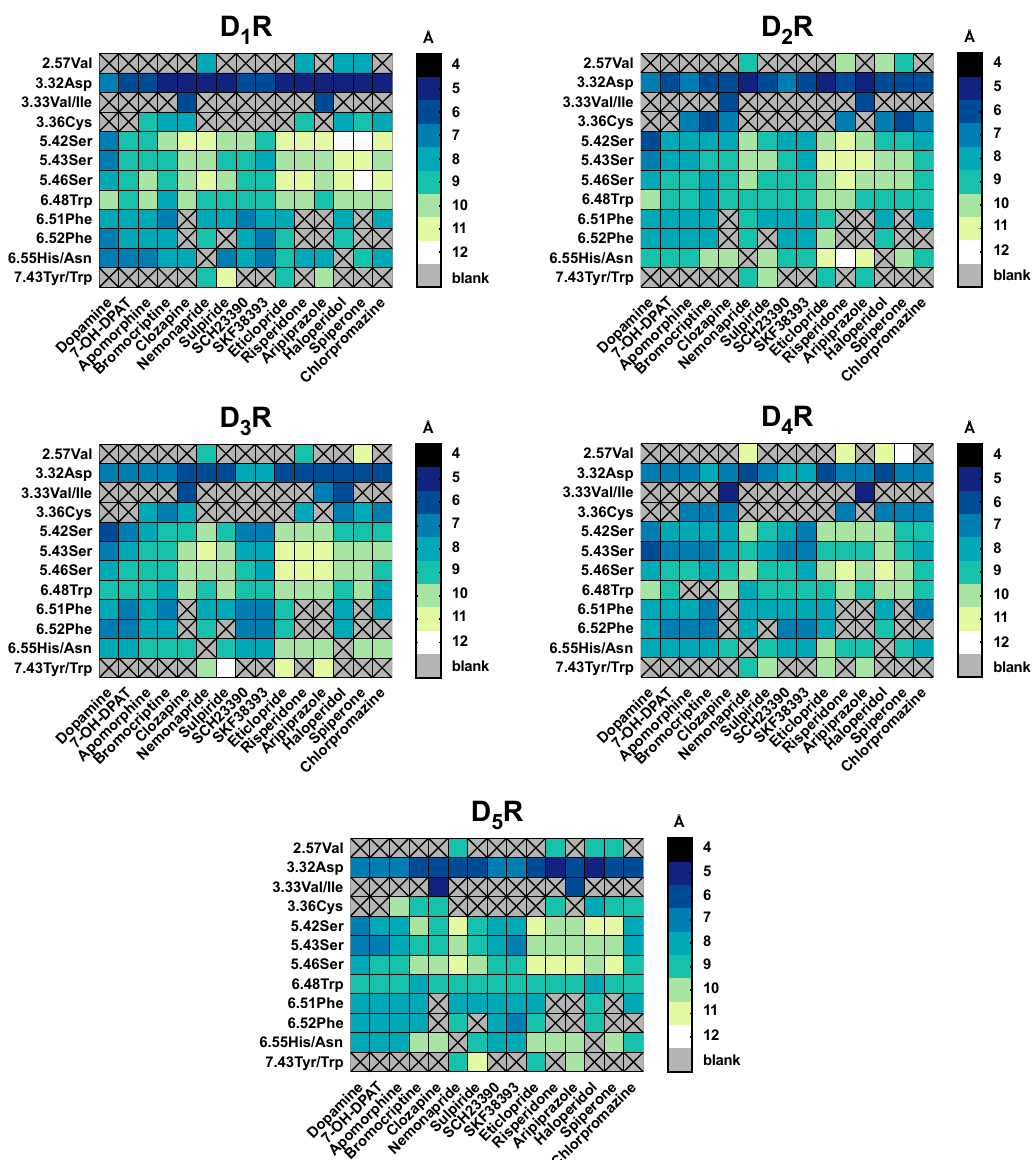
Figure 5. Summary of the distances between ligands and residues used in molecular docking for all DR subtypes. For each ligand-residue-distance [Å], we calculated the mean of all time points of the conformational models (11) of the three best docked clusters ranked by binding energy [kcal/mol] Noteworthy is that not all ligands were set to interact with all residues shown in the x-axis in the molecular docking. (e.g., only clozapine and aripiprazole were set to interact with 3.33Val). The distances are color coded: while dark colors indicate short distances, light colors indicate wider distances.